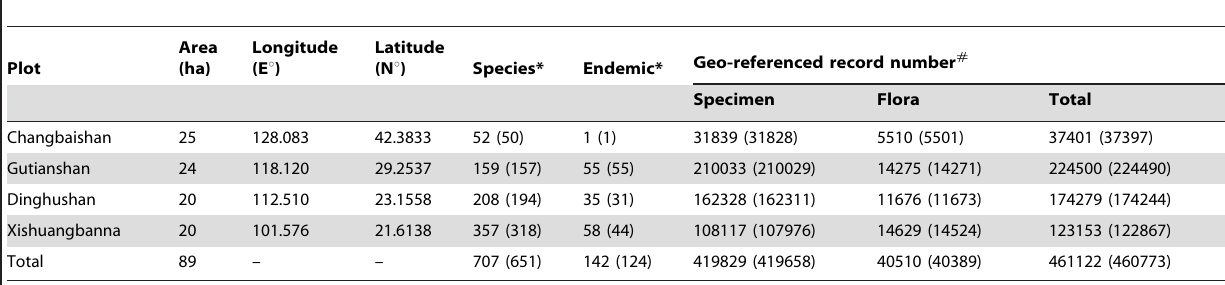
Table 1. Size, geographic location, number of species, and endemics to China for the four census plots, plus the geo-referenced record number for those